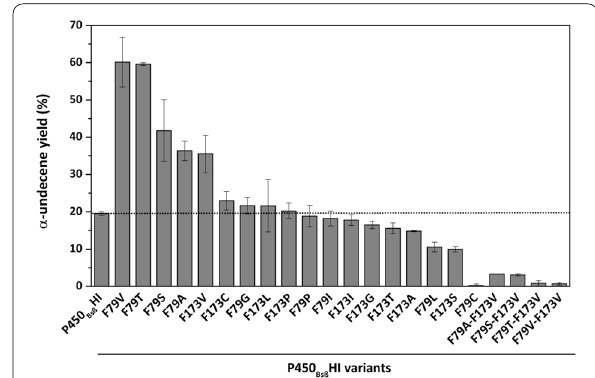
Fig. 3 Evolution of the activity of P450 Bsβ HI variants towards the decarboxylation of lauric acid. The α-undecene products were qualitatively determined by contrasting with standard sample, and quantified by external standard method. Every bio-catalytic system contained 10 µM P450 Bsβ HI enzyme (or its variants), 500 µM lauric acid substrate (from a 100 mM stock solution in ethanol) and 1 mM H 2 O 2 in a final volume of 1 mL of 100 mM potassium phosphate buffer (pH 8.0). Results shown are mean SD of duplicated = ± experiments